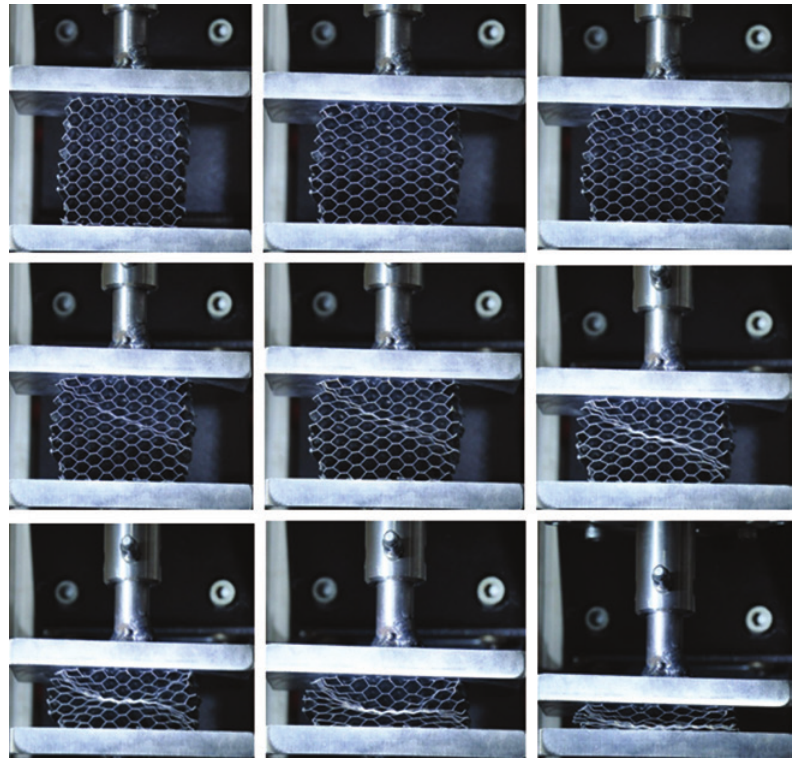
Figure 5 The deformation process of aluminum honeycomb compressed in x